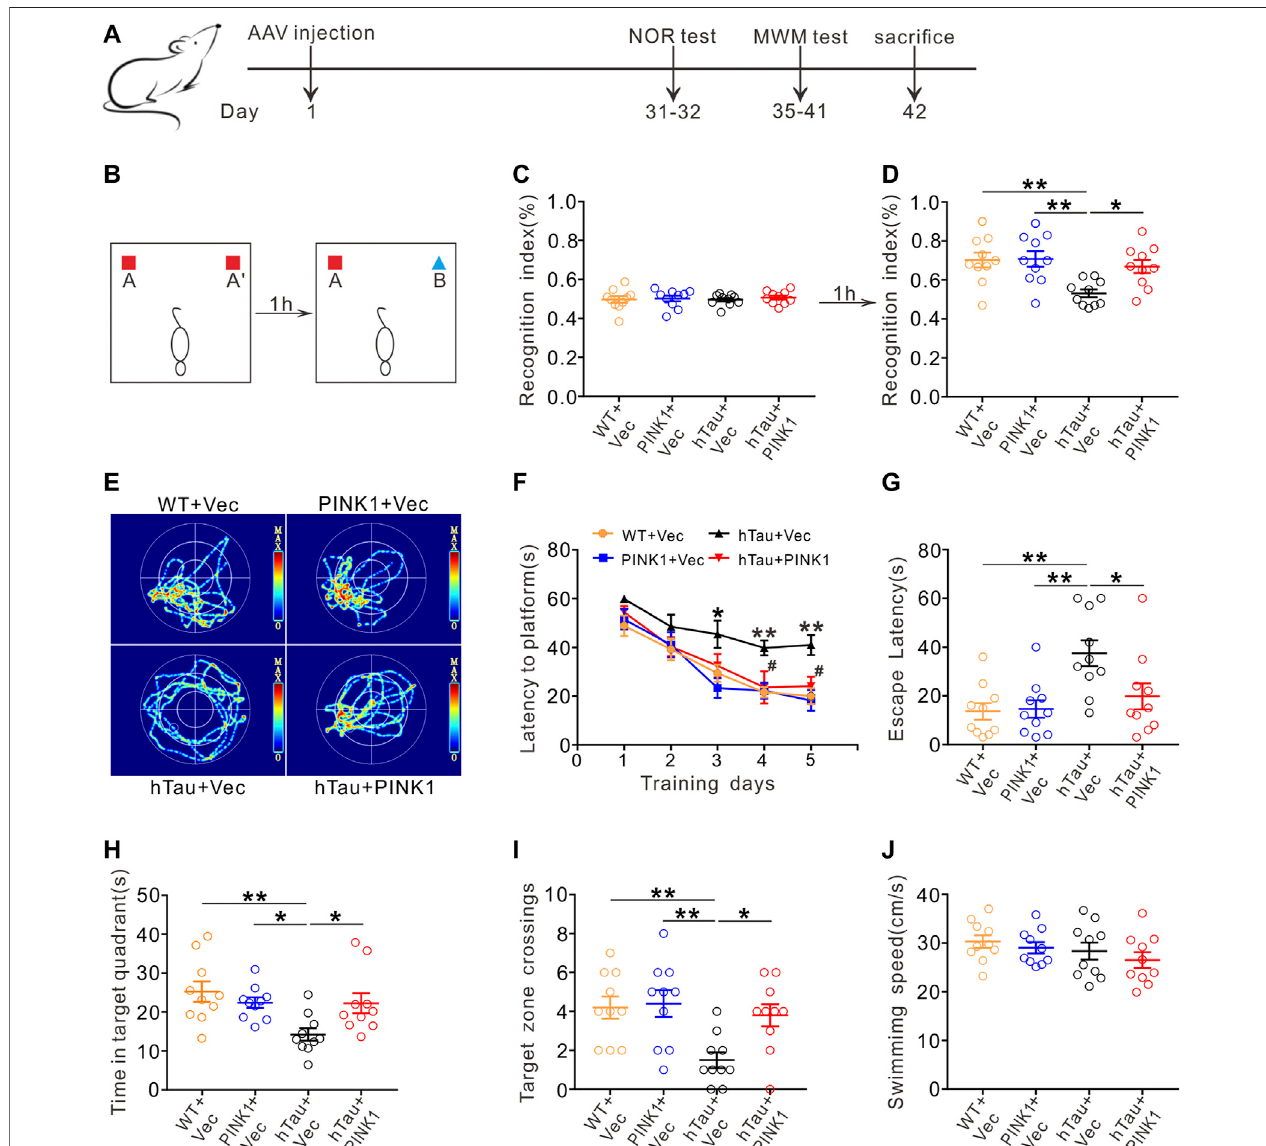
FIGURE 1 | PINK1 ameliorates cognitive impairments in hTau mice. (A) Experimental processes of virus injection and behavioral tests. (B – D) PINK1 improved cognitive performance of hTau mice in the NOR test shown by elevated recognition index. One-way ANOVA followed by Tukey multiple-comparisons tests. * p < 0.05, ** p < 0.01. (E) Representative swimming path of mice in each group during the MWM probe test. (F) PINK1 improved learning ability in hTau mice shown by shortened latency to fi nd the hidden platform during training stage in the MMW test. Two-way repeated-measures ANOVA followed by Tukey multiple-comparisons tests. * p < 0.05, ** p < 0.01 vs. WT + Vec; # p < 0.05 vs. hTau + Vec. (G – I) PINK1 improved memory ability in hTau mice shown by decreased latency to reach the location of platform (G) , longer retention time in the target quadrant (H) , and more target zone crossings (I) during the MWM probe test. One-way ANOVA followed by Tukey multiple-comparisons tests. * p < 0.05, ** p < 0.01. (J) No signi fi cant difference in swimming speed was seen among the four groups during the MWM probe test. One-way ANOVA followed by Tukey multiple-comparisons tests. All data were presented as mean ± SEM. n (cid:2) 10 mice for each